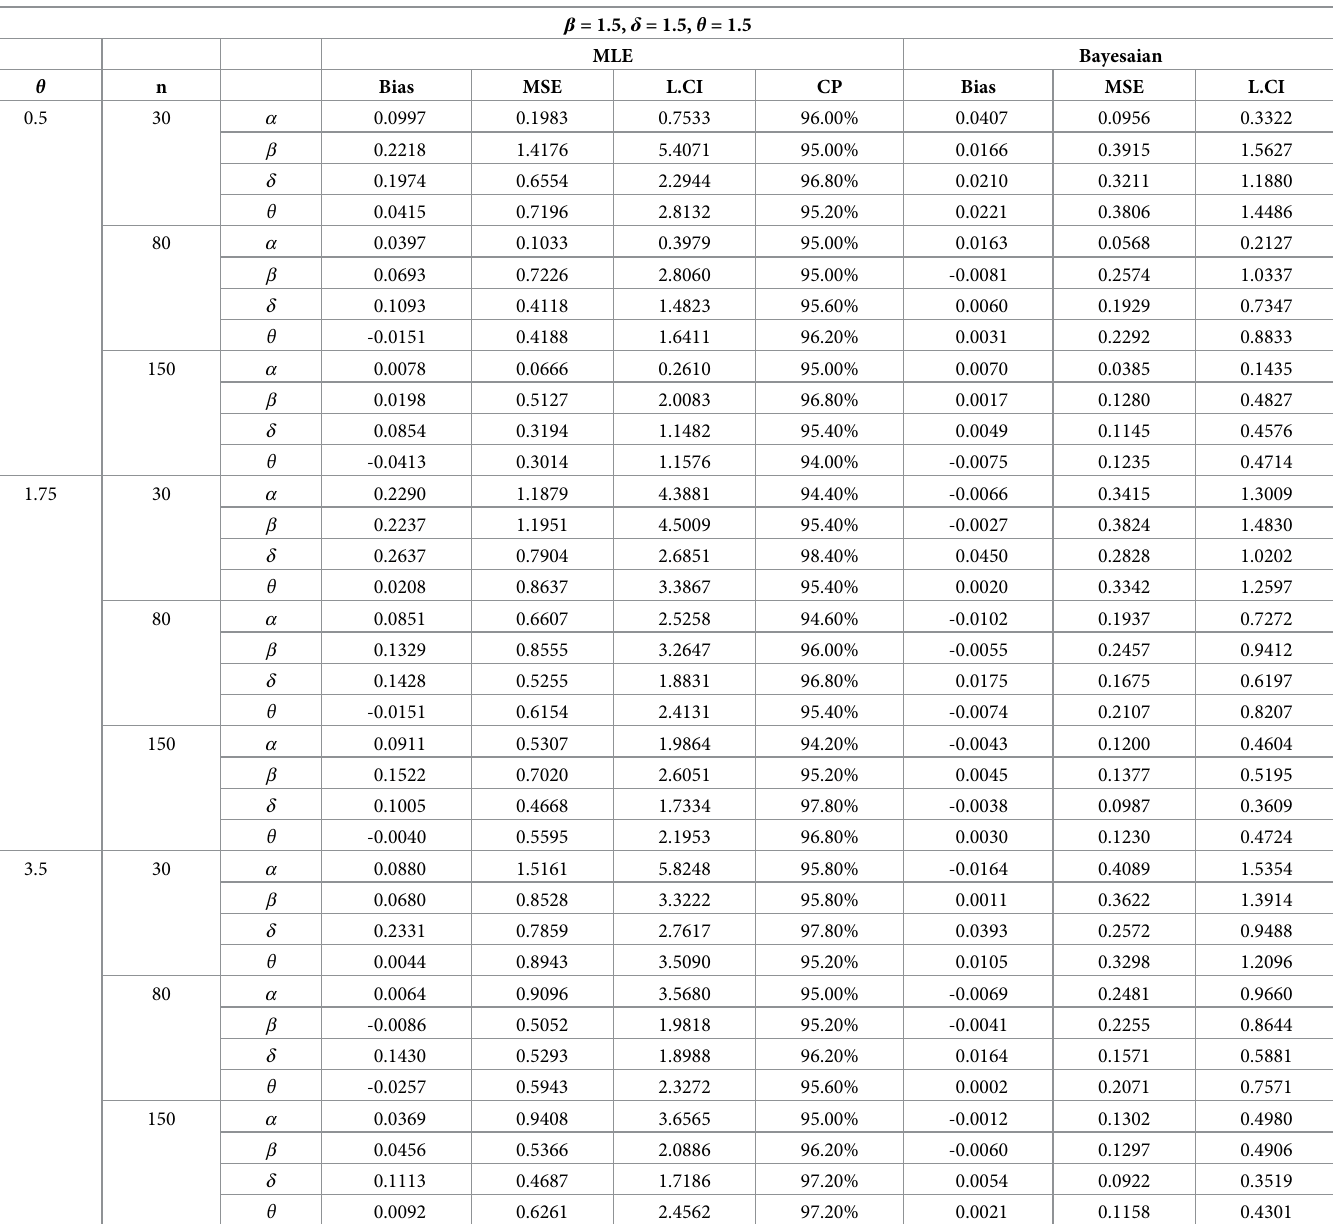
Table 3. RB, MSE, and length of CI of OLINH distribution for MLE, and Bayesian when β = 1.5, δ = 1.5, θ =